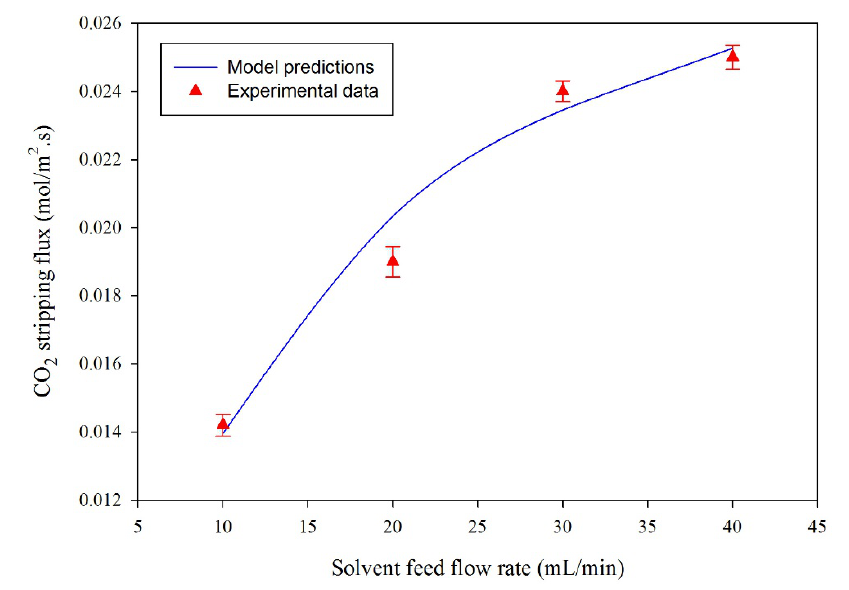
Figure 9. Effect of solvent feed rate on the flux and CO 2 removal flux. Fiber made of 28% PVDF, 72% triacetin, module (length is 260 mm, inner diameter is 8 mm), hollow fibers (ID/OD: 0.42/1.1 mm). Initial CO 2 concentration in rich PG is 0.54 mol/L. Solvent feed temperature = 80 °C and gas feed flow rate is 100 mL/min. The experimental uncertainty of CO 2 removal flux is ±0.0005.